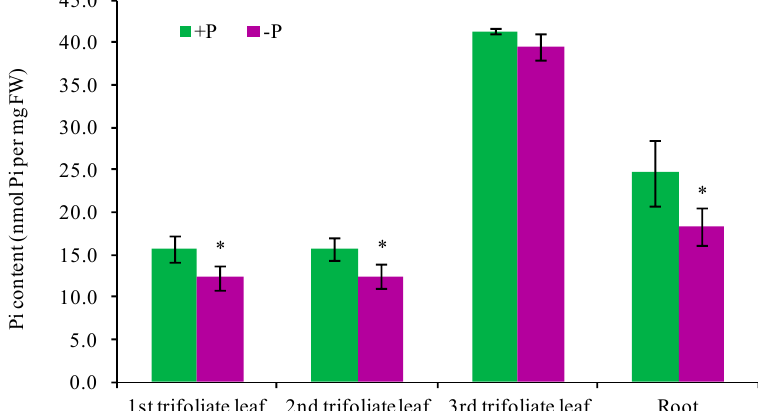
Figure 1. Pi concentration in the first trifoliate leaf (1st TL), the second TL (2nd TL), the third TL (3rd TL) and the roots of soybean seedlings after being subjected to Pi-deficiency treatment for 24 h. Data presented are mean ± SD (standard deviation) of three independent experiments. Asterisk indicates the statistically significant difference between control (+P) and Pi-deficiency ( − P) treatments (Student’s t -test, * p < 0.05) (Microsoft Excel 2007).